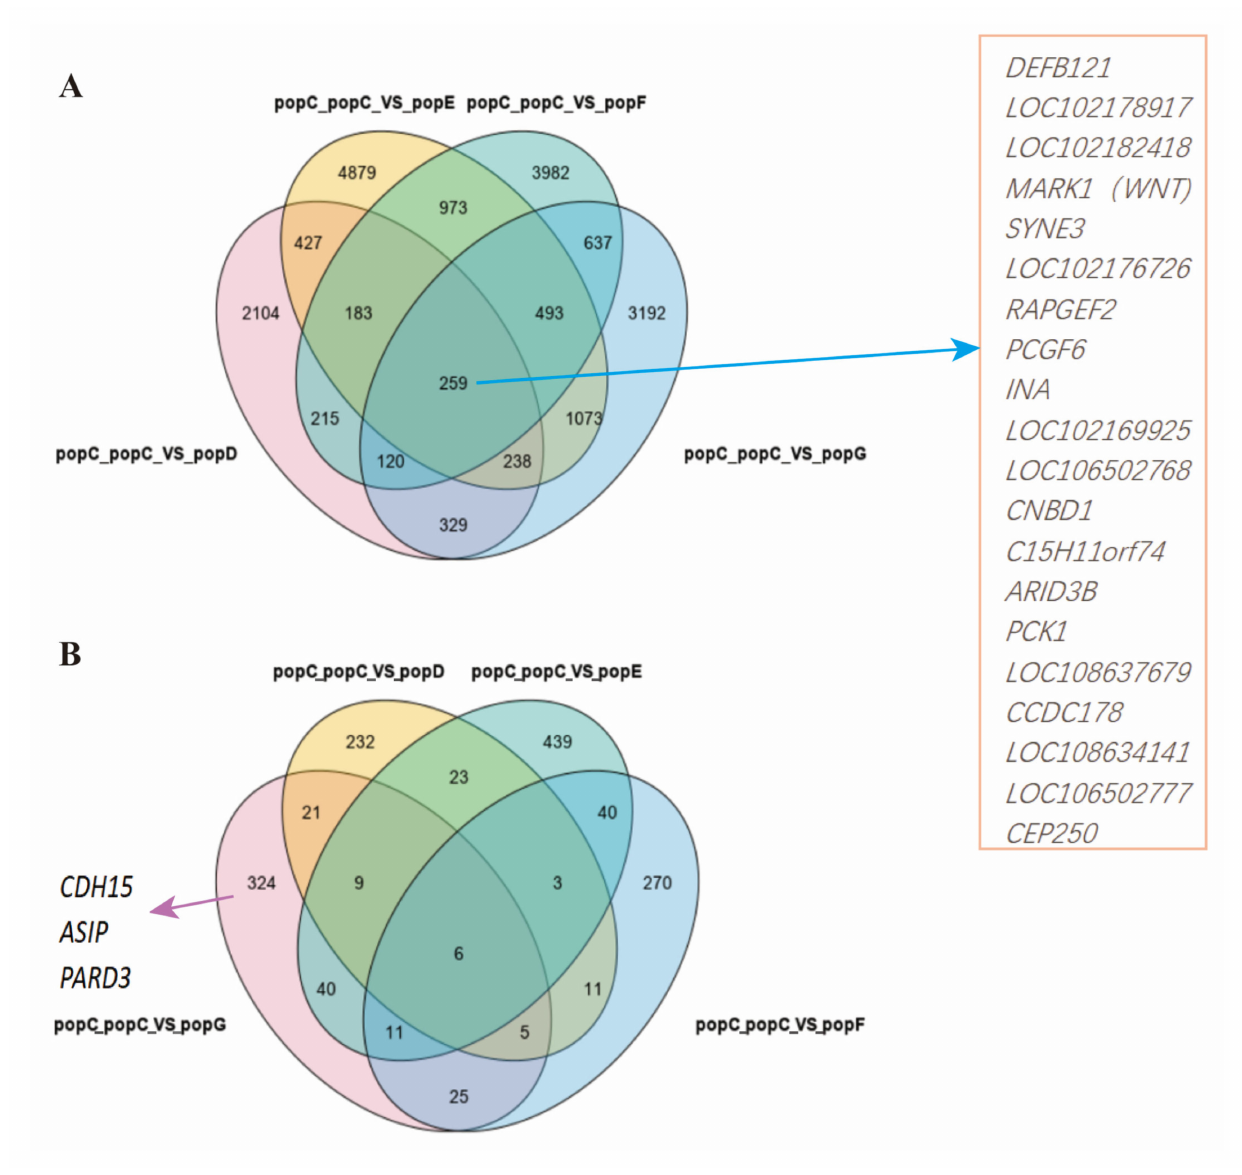
Figure 7. ( A ) Venn diagram of the Hainan Black goat selective signals regions. A total of 20 genes are listed in the red box and are genes in the selection signal region of the Hainan Black goat between popC (Hainan Black goat) and popD (Dazu Black goat), popE (Jining Grey goat), popF (Boer goat), and popG (Alashan Cashmere goat). ( B ) Venn diagram of the Hainan Black goat selective genes. CDH15 , ASIP, and PARD3 are melanin-related genes and are Hainan Black goat selective genes between the popC (Hainan Black goat) group and the popG (Alashan Cashmere goat) group. PopC_popC vs. popE, PopC_popC vs. popE, PopC_popC vs. popF, and PopC_popC vs. popE represent (compared to popD, PopE, and_popF) the selective signal regions or selective genes in